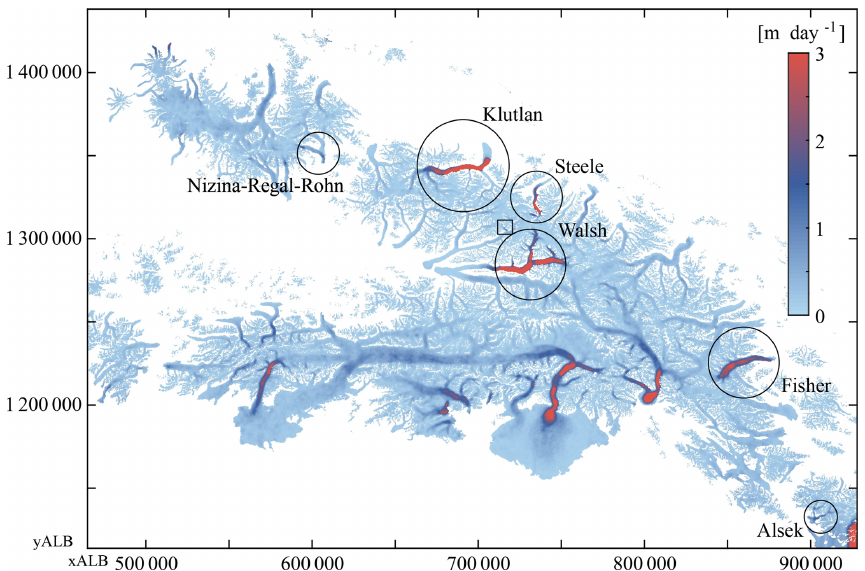
Figure 13. Spread of variation in flow speed (using the difference between the 20th and 80th percentiles) over the observed period (2013– 2018). Different dynamic glaciers are encircled, and the square indicates the tributary glacier shown in Fig.